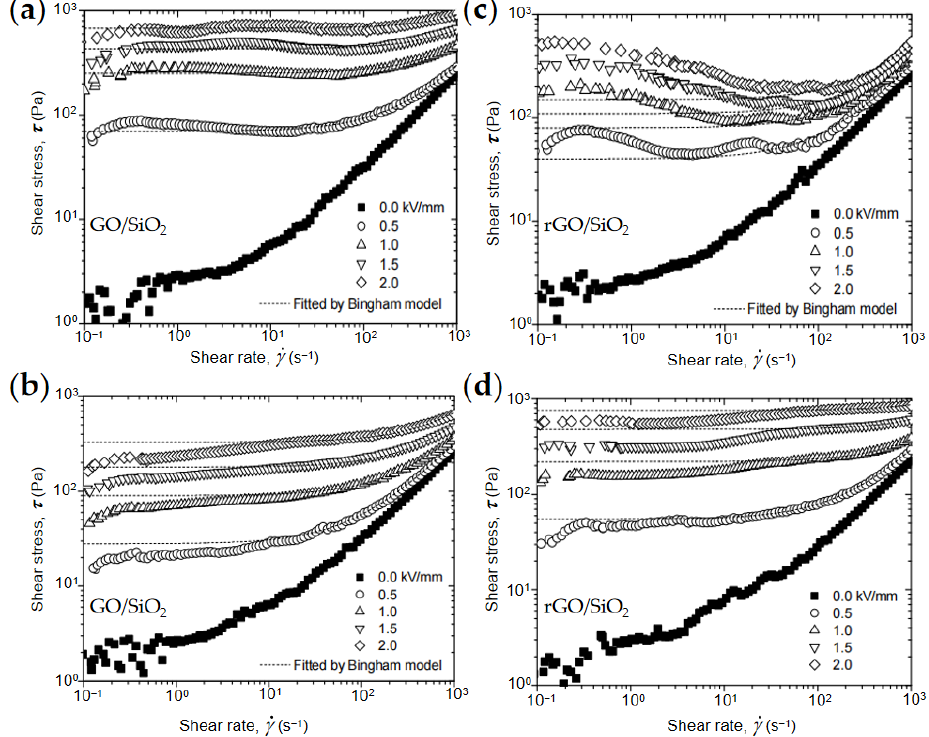
Figure 11. Flow curve of shear stress–shear rate of ER fluids of GO/SiO 2 under DC electric field ( a )